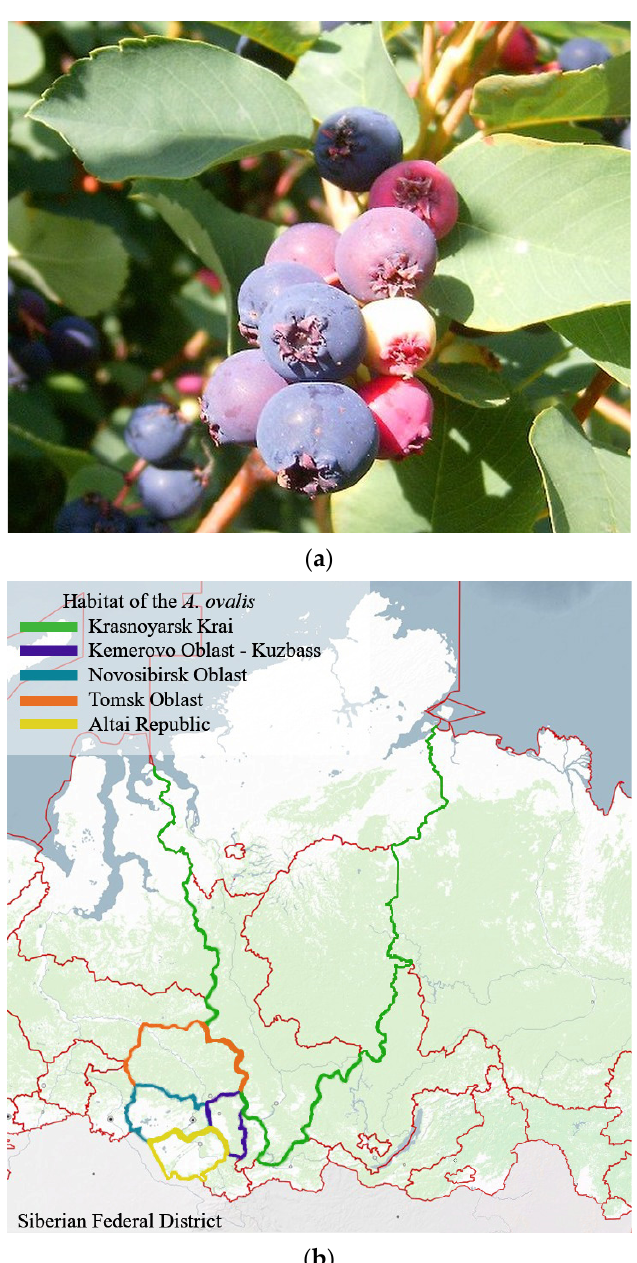
Figure 1. Photo of the berries Amelanchier ovalis ( a ) and public cadastral map of Siberian Federal District, Russia ( b ).